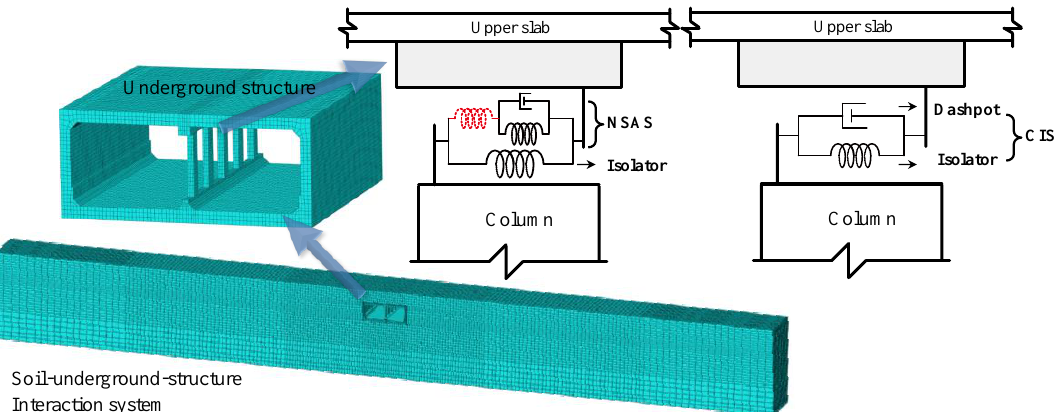
Figure 4. Model of soil–underground structure interaction system controlled by conventional isolation system (CIS) and by NSAS combined with an isolator.